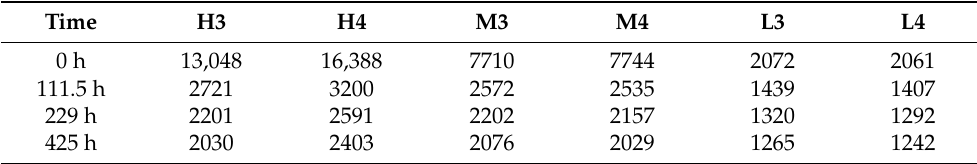
Table 4. Changes of Q-factor of different samples under high-temperature baking at 105 ◦ C.